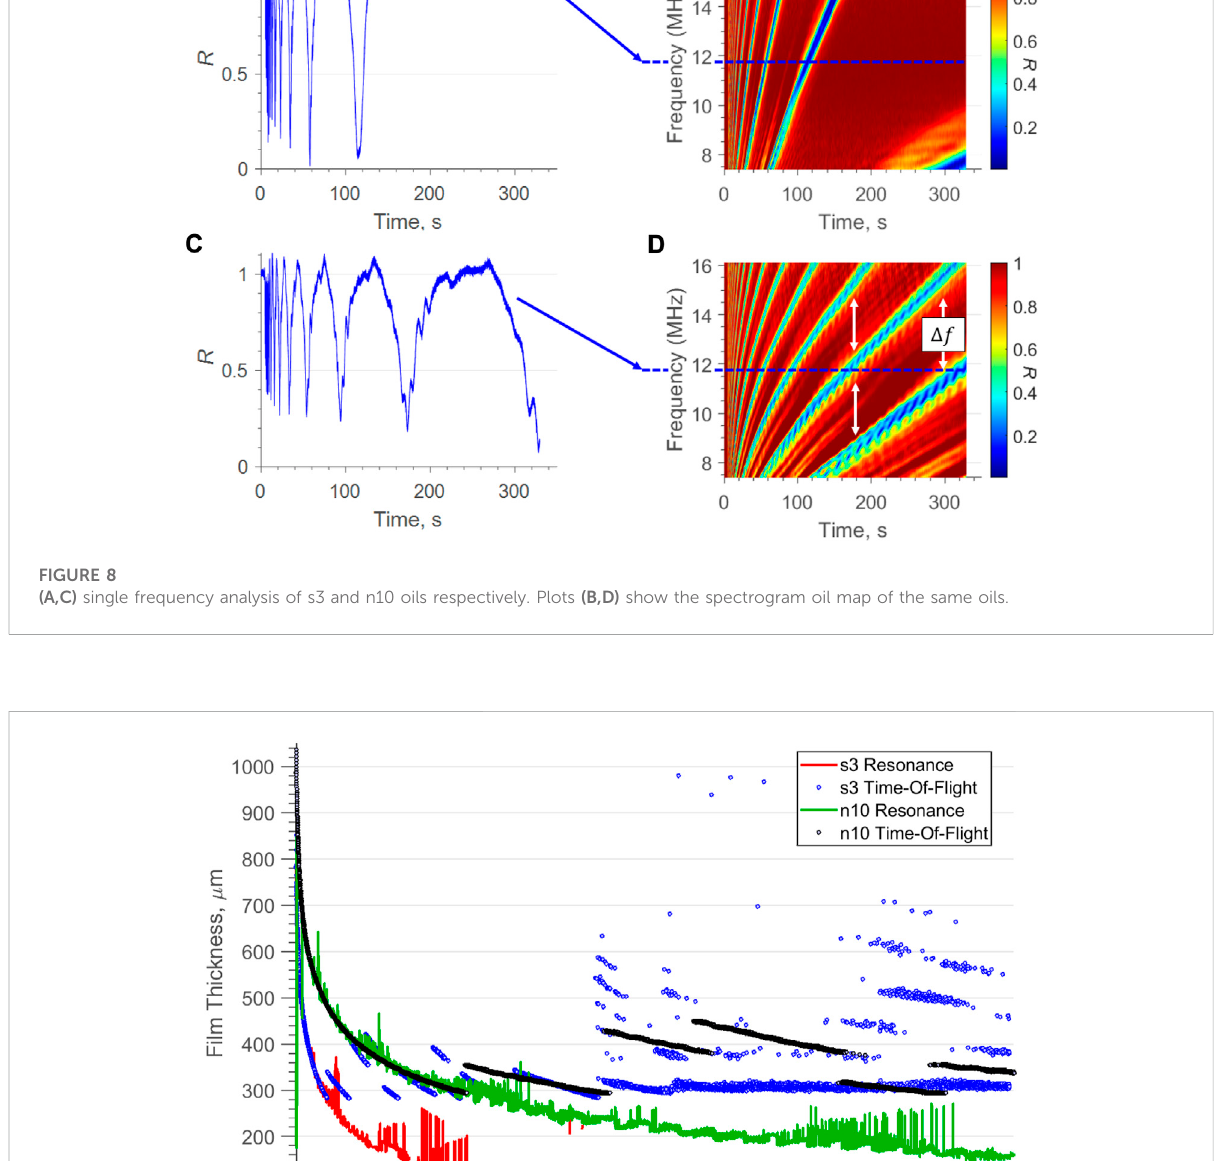
intensity of the plot has been limited between 0.95 ≤ R ≤ 1.00 to improve the contrast around the resonant R values. 4 distinct areas are highlighted on the plot: